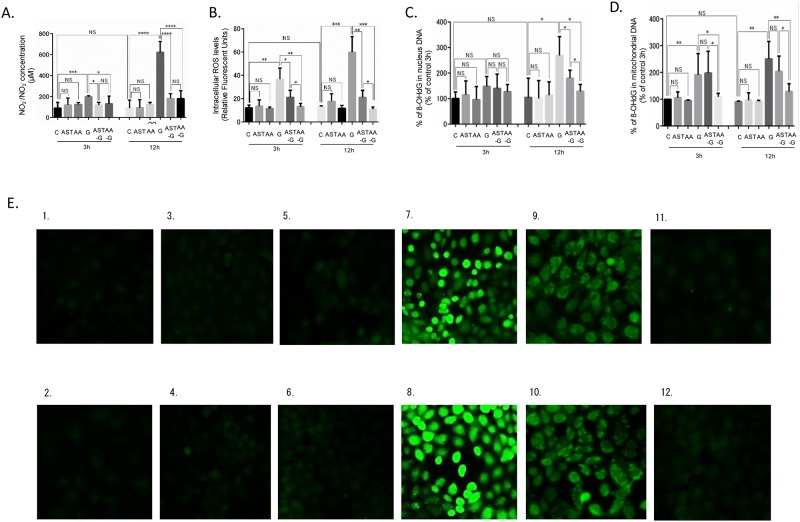
Effect of high glucose stimulation, AST, and AA to TSMCs as for ROS.(A) NO2−/NO3− concentration in medium supernatant of each group. (B) Intracellular ROS levels of each group. (C) 8-OHdG ratio in mitochondrial DNA of each group. (D) 8-OHdG ratio in nuclear DNA of each group. AST concentration: 5 μM, AA concentration: 100 μM. NS: no significant change. *: p < 0.05. **: p < 0.01. ***: p < 0.0005. ****: p < 0.0001. Error bars represent SD. (E) ROS fluorescence of each group (1) C3h group, (2) C12h group, (3) AST3h group, (4) AST12h group, (5) AA3h group, (6) AA12h group, (7) G3h group, (8) G12h group, (9) AST-G3h group, (10) AST-G12h group, (11) AA-G3h group, and (12) AA-G12h group. Fluorescence solution was 2′, 7′-dichlorodihydrofluorescin diacetate (DCFH-DA).